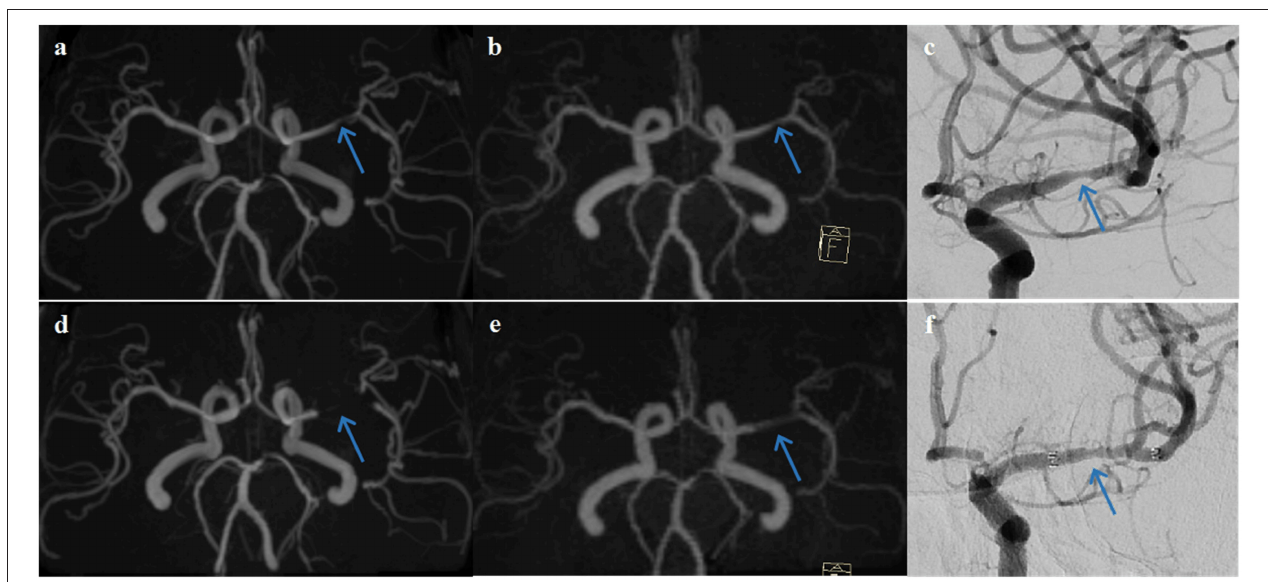
FIGURE 4 | A representative case of a 63-year-old female patient who underwent stent angioplasty due to atherosclerotic stenosis of the left middle cerebral artery (MCA) at the M1 segment (blue arrows). Pre-intervention images are shown on the top row (a) TOF-MRA, (b) PETRA-MRA, and (c) DSA. The degree of stenosis was 79.8% on TOF, 65.3% on PETRA-MRA, and 68.6% on DSA. Image quality scores of the PETRA-MRA and 3D-TOF were both 4. Post-intervention images are shown on the bottom row (d) 3D-TOF, (e) PETRA-MRA, and (f) DSA. Post-intervention TOF-MRA had strong signal loss near the stent, and post-intervention PETRA-MRA had mild signal loss near the stent comparing with reference DSA. PETRA-MRA had significantly higher image quality scores than those of TOF-MRA considering flow visualization within the stents (PETRA-MRA, 4; 3D-TOF, 1) and susceptibility artifact (PETRA-MRA, 3; 3D-TOF, 1).